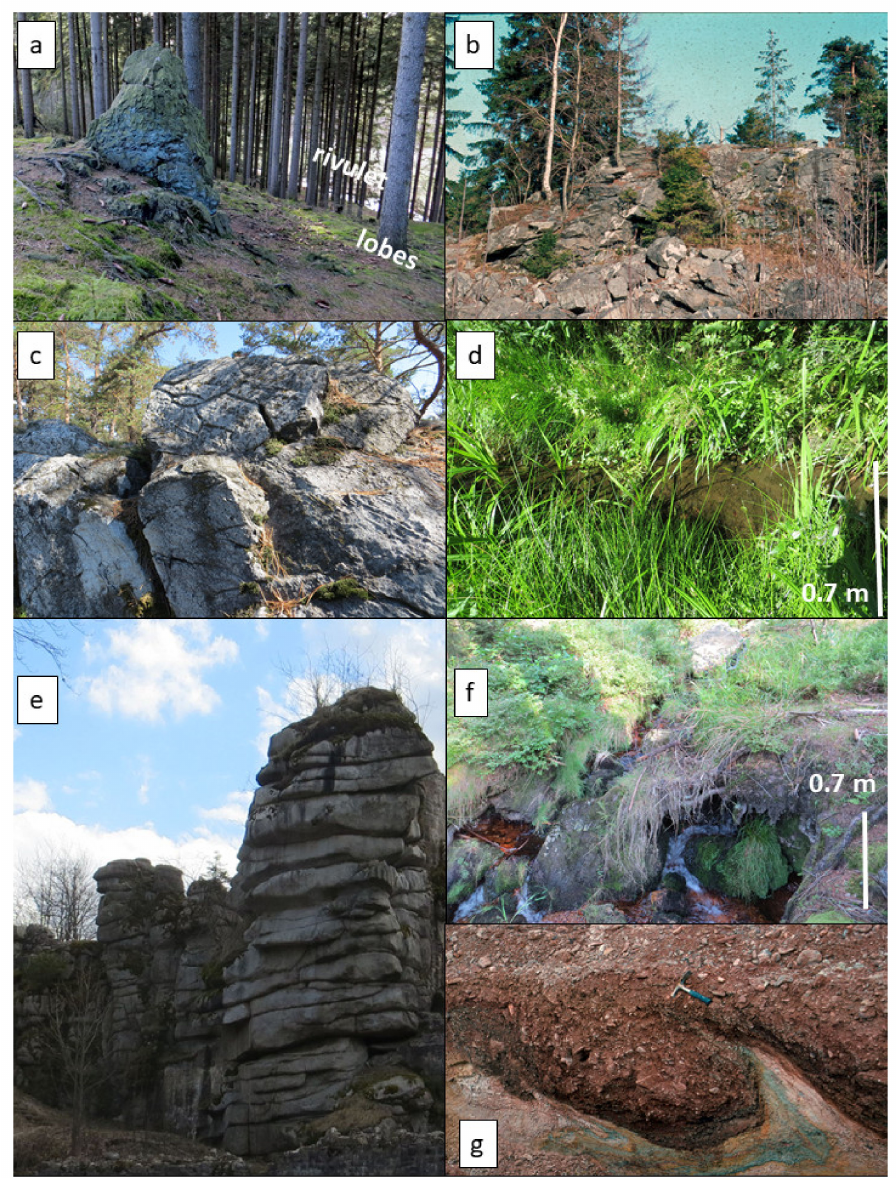
Figure 7. Landforms created by mass wasting and cryogenic processes associated in the SSS. ( a ) Pinna- cle of Ordovician very angular quartzite and siliceous slates (VGL-type) on a hilltop of the 580–620 m level upslope of a straight channel (rivulet) with lobes of confined soil and talus creep, inactive on account of being densely forested by softwood trees (slope angle 25 ◦ ⇒ 30 ◦ ). ( b ) Monadnock at outcrop as angular to subangular palisades (LHG-type) of eclogite-amphibolite intruded by white veinlets of zoisite pegmatoid on top of the 580–620 m level (668 m) passing from blockfields into boulder strewn gently dipping slopes (slope angle 10 ◦ ⇒ 15 ◦ ). ( c ) Monadnock with subrounded exposures of bronzite-serpentinite (LHG-type) displaying typical features of “silica karst” on top of the 580–620 m level (589 m) (slope angle 15 ◦ ⇒ 20 ◦ ). ( d ) The bronzite-serpentinite is surrounded by an apron of solifluction lobes deprived of any gravelly rock fragments, with waterlogged meadows. They are cut by a network of alluvial channels filled down to a depth of 0.5 m with muddy hillwash (slope angle 10 ◦ ⇒ 15 ◦ ). ( e ) Rounded boulders piled up as tors on top of the Central Granite G1 (LGG-type) (slope angle 10 ◦ ⇒ 15 ◦ ). ( f ) Subrounded blocks of the Core Granite G3 embedded into grus and dislodged into one of the channels of the Steinach River in the CA (LGG-type) (slope angle 5 ◦ ⇒ 15 ◦ ). ( g ) Pocket in the bedrock of the Steinach River filled with cryoturbated gravel. It is overlain by fluvial gravel in the DA